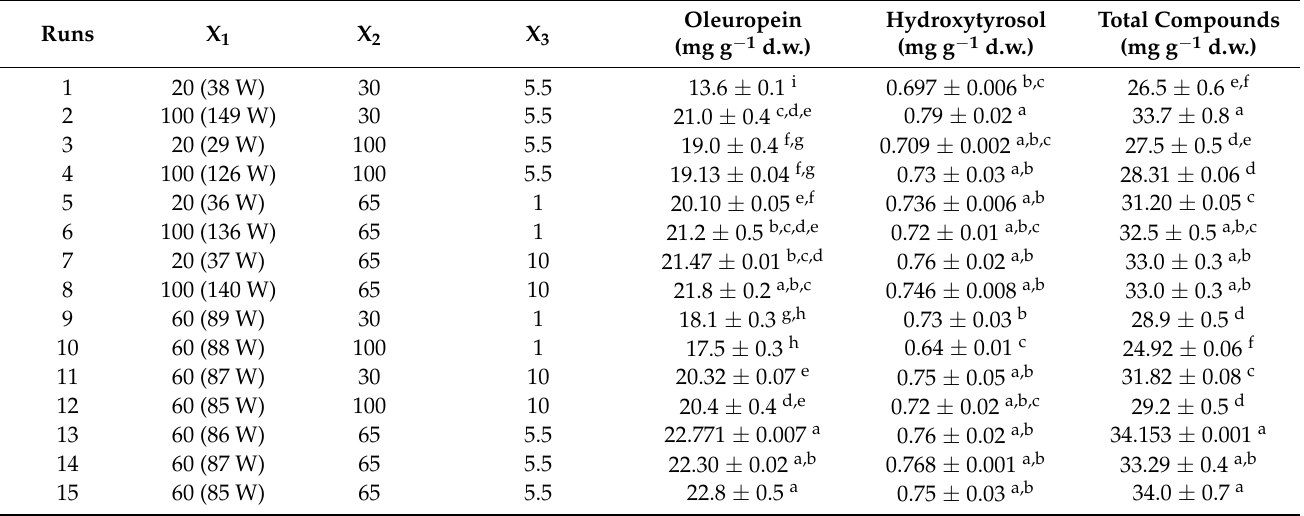
Table 1. Box–Behnken design with sonotrode parameters and values for dependent variables obtained (oleuropein, hydroxytyrosol and total compounds) quantified by HPLC–MS ‘Koroneiki’ in olive leaves. Results are expressed as mean ± standard deviation in mg g − 1 dry matter of olive leaves. Different letters in the same column indicate significantly different values ( p <